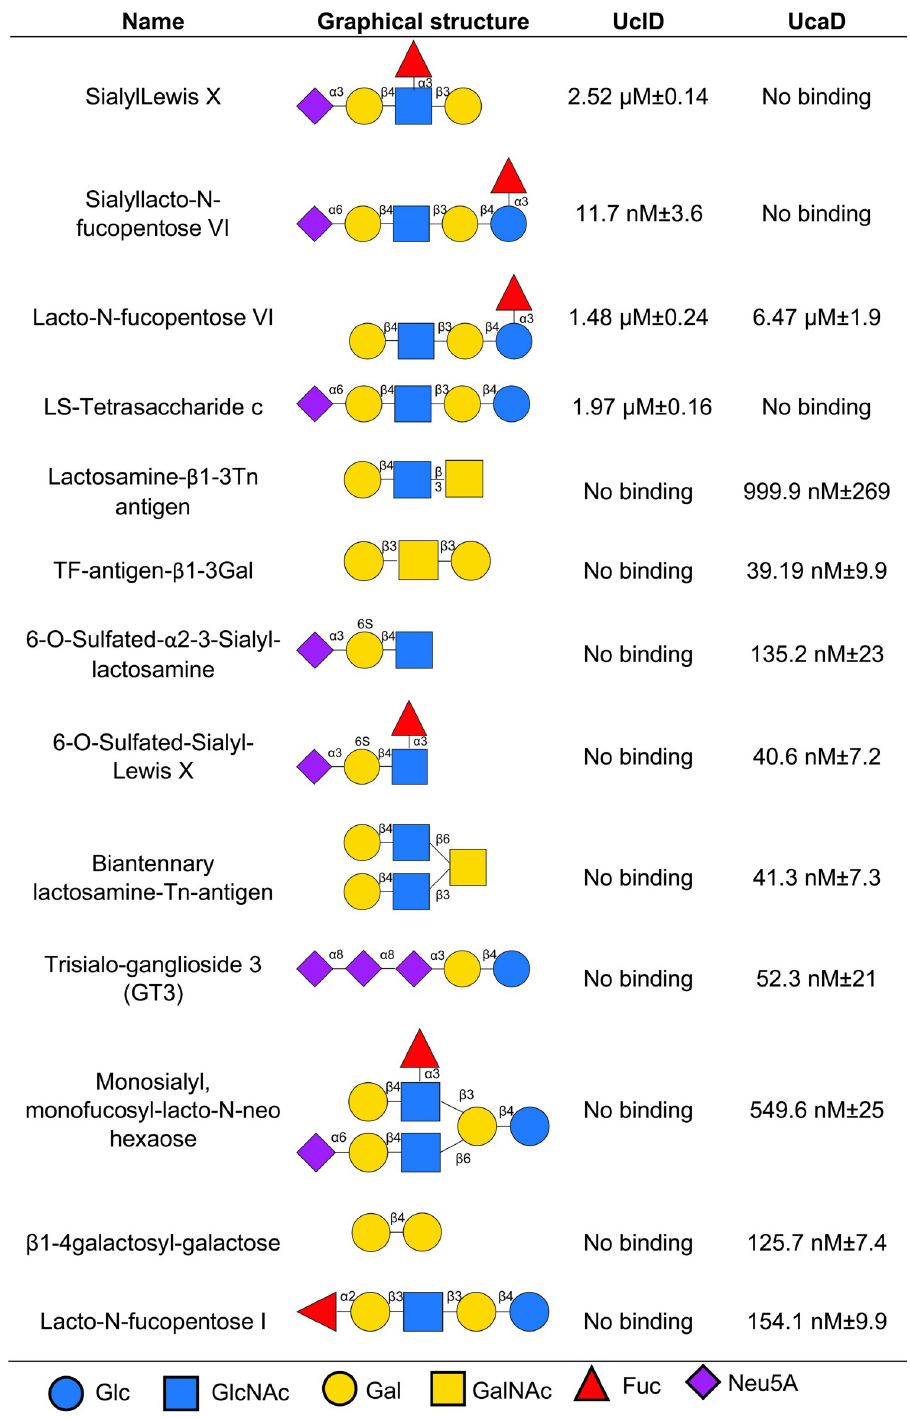
Fig 5. Glycan interactions and binding affinity with UclD and/or UcaD. Shown are the glycans, together with their graphical structure and binding affinity to UclD LD and/or UcaD LD determined by SPR.